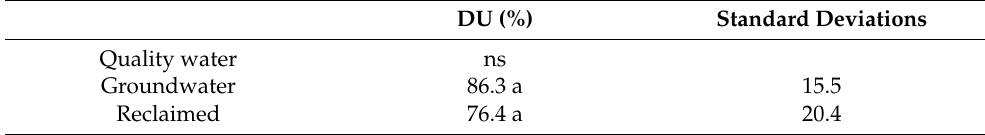
Table 5. Distribution uniformity (%) depending on the water quality.